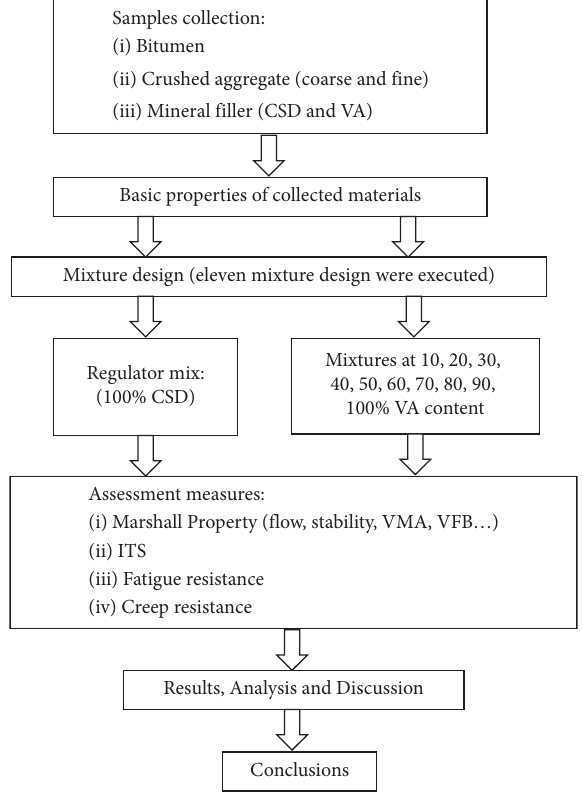
Figure 1: Framework of